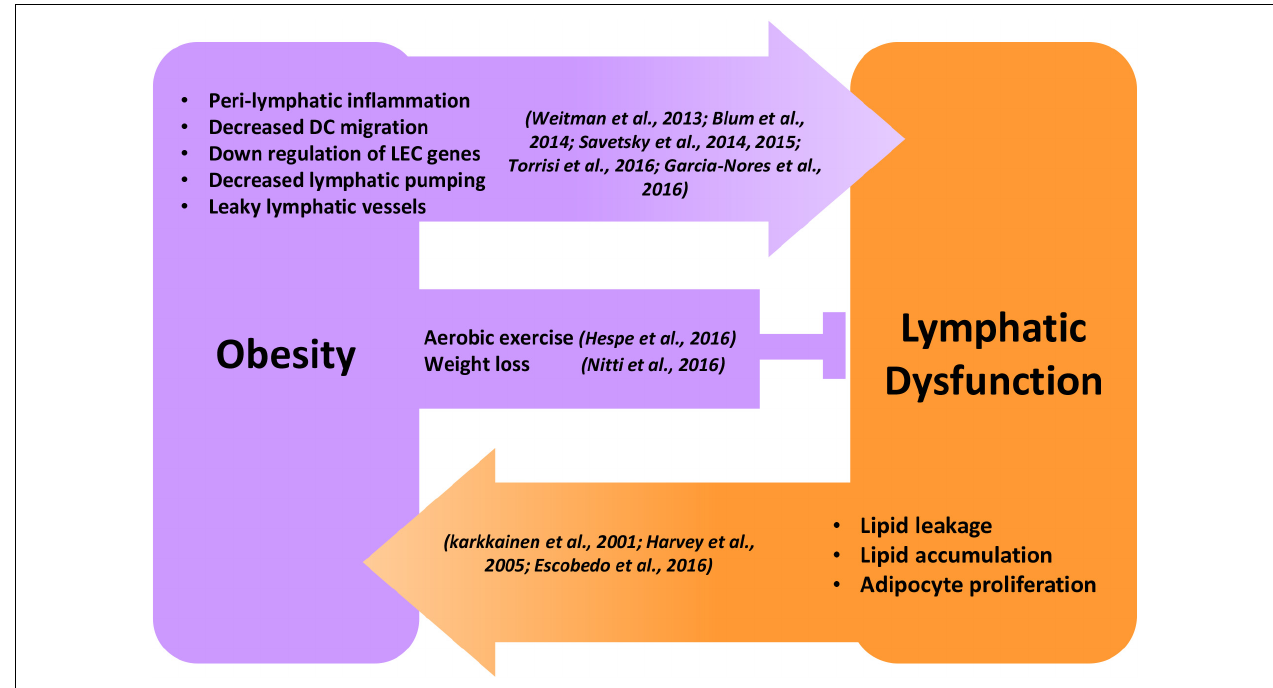
FIGURE 1 | Reciprocal regulation of obesity and lymphatic dysfunction. Schematic illustration showing the reciprocal regulation of obesity and lymphatic dysfunction. Peri-lymphatic inflammation in obesity causes decreased lymphatic pumping, DC migration, LEC gene expression, and increased lymphatic leakage leading to lymphatic dysfunction. Behavioral interventions like aerobic exercise and weight loss inhibit and reverse obesity-induced lymphatic dysfunction. Genetic or surgical lymphatic damage or dysfunction causes malabsorption of lipids, adipocyte proliferation, and progressive accumulation of adipose tissue, leading to obesity.